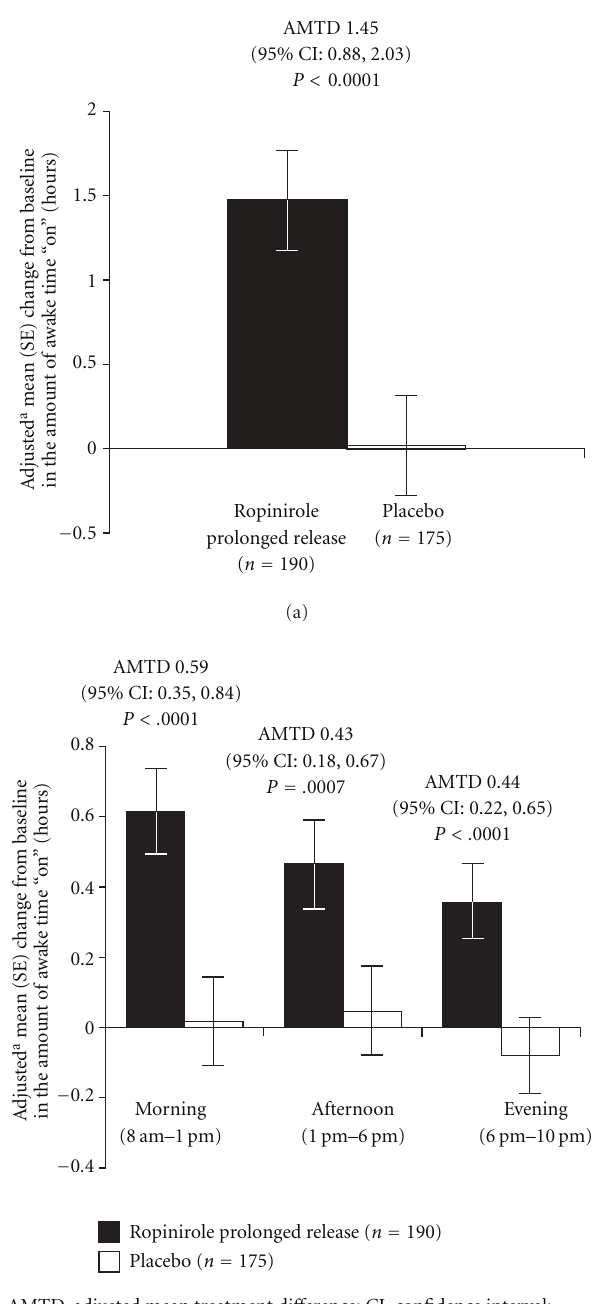
Figure 3: a Adjusted mean change from baseline in theamount of awake time spent “on” (hours) at week 24 LOCF (intent-to-treat population) (a) during the daytime (8am–10 pm); (b) during each period of the